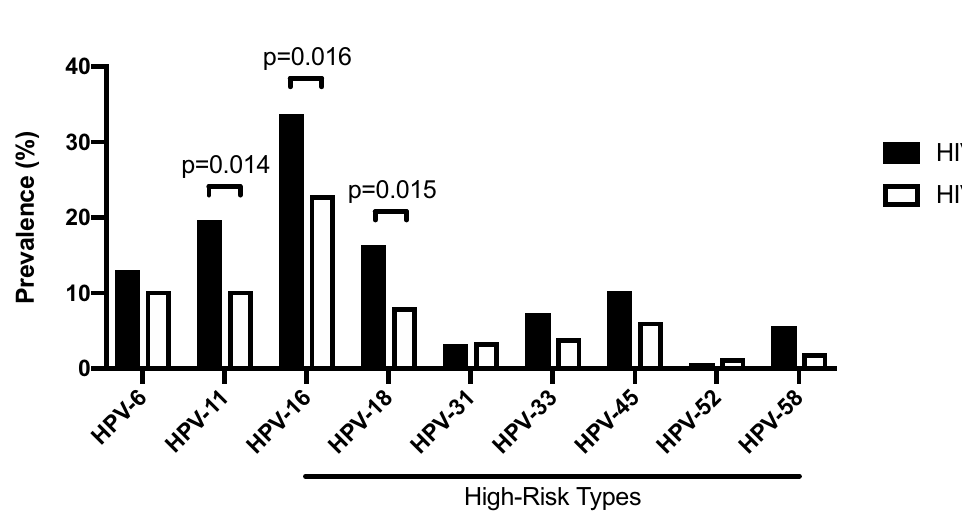
Figure 1. Genotype-specific prevalence of anal HPV infection in the HIV-positive (n = 294) and HIV-negative participants (n =